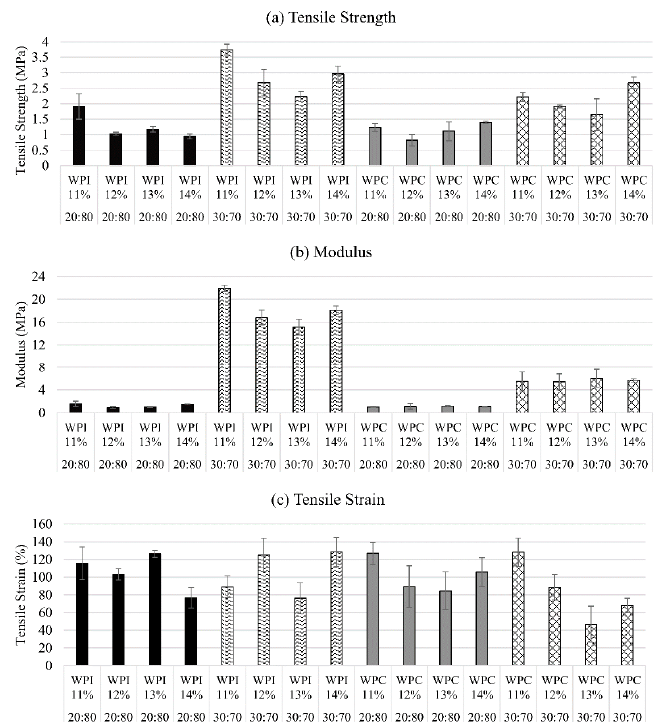
Figure 4. Average ( a ) tensile strength ( b ) modulus and ( c ) tensile strain, of all polymer samples, all with error bars at 95% confidence level. Each group of bars color / pattern is a set of 4 di ff erent protein concentrations in water from 11–14 w / v